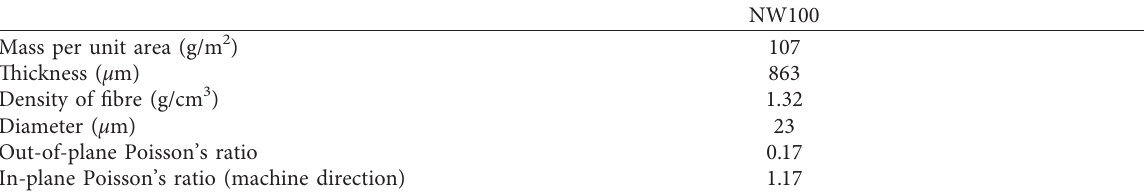
Table 1: Properties of nonwoven geotextiles and